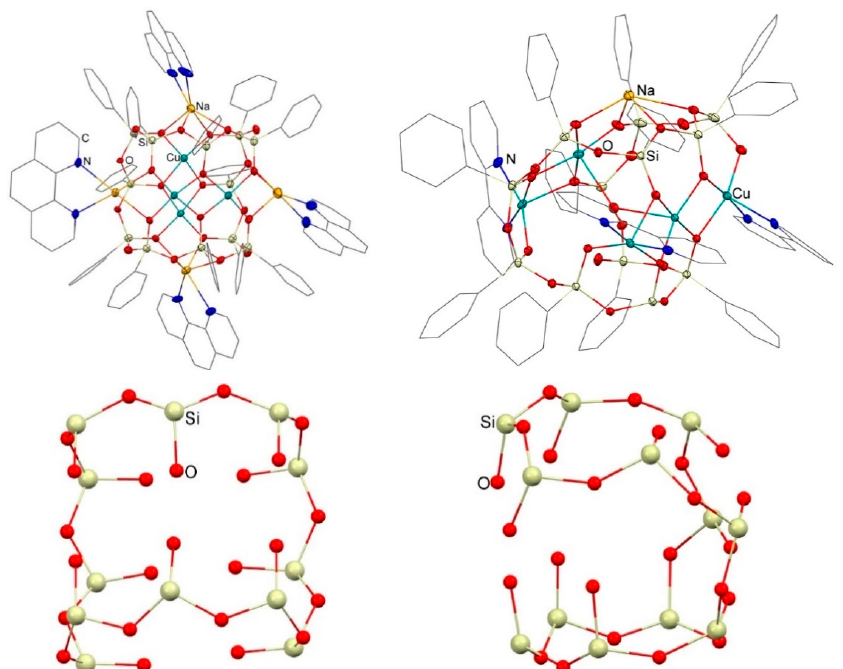
Figure 1. Top left: Molecular structure of 1. Top right: Molecular structure of cage metallasilsesquioxane (CLMS) from ref. 8b. Solvating molecules of THF are not shown for clarity. Bottom left: Structure of silsesquioxane Si 12 -ligand in 1. Bottom right: Structure of silsesquioxane Si 12 -ligand in CLMS from ref.